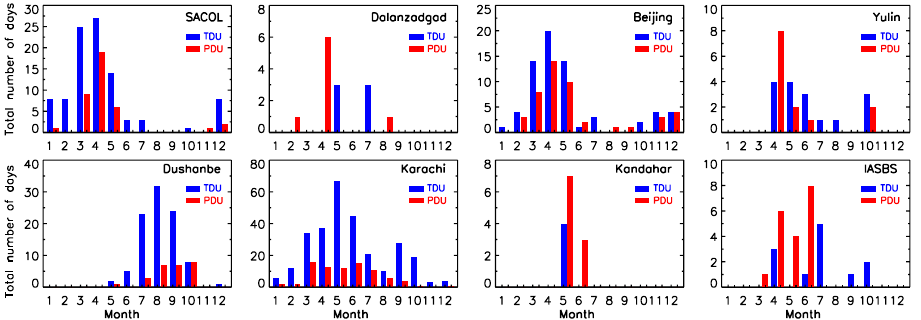
Figure 2. Occurrence frequency of total number days for Pure Dust ( α <0.2, PDU with red color) and Transported Anthropogenic Dust (0.2< α <0.6, TDU with blue color) at four selected East Asian sites (top panel) and four Central Asian sites (bottom